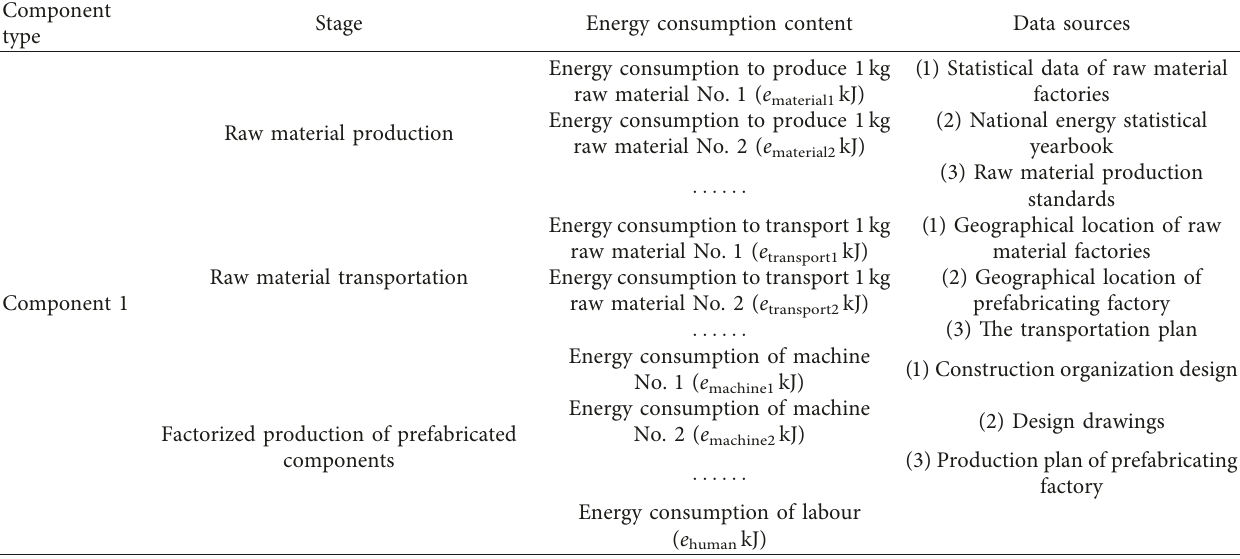
Table 2: Energy consumption inventory of prefabricated component